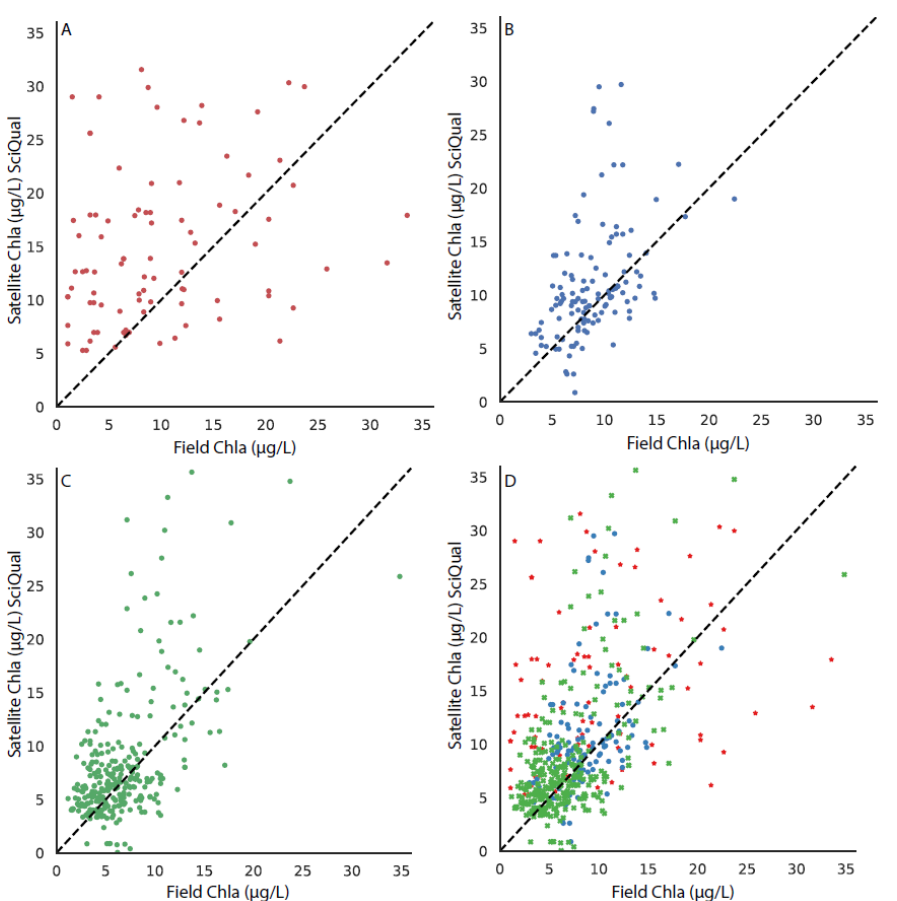
Figure 8. The matchup between the field chla and the VIIRS-SciQual algorithm, with the 1:1 line shown in each subplot for stations in ( A ) the upper bay, ( B ) the middle bay, ( C ) the lower bay, and ( D ) all stations, with the upper, middle, and lower bays differentiated by symbol color and style.